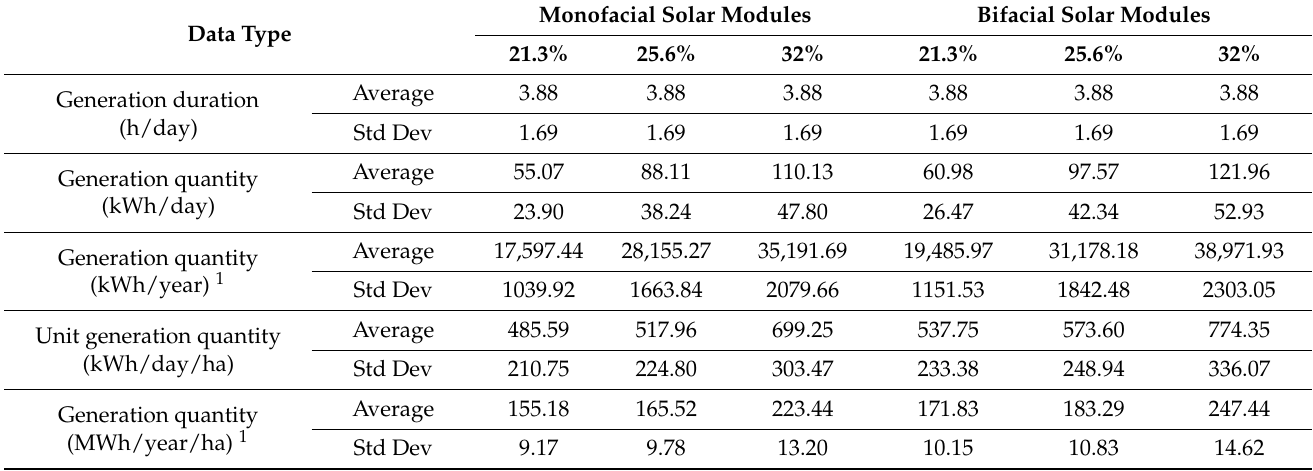
Table 5. Electricity generation data from the APV